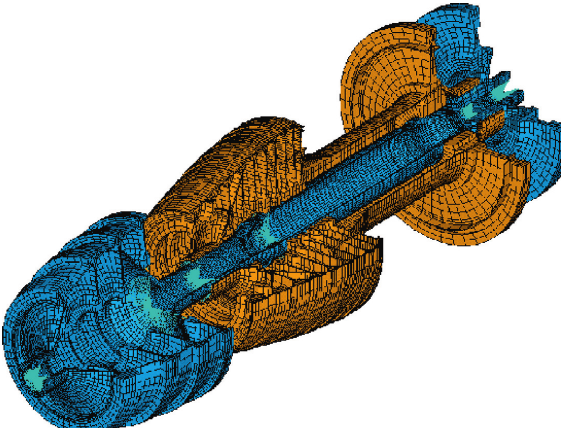
Figure 4: A three-dimensional solid finite element model of the dual-rotor